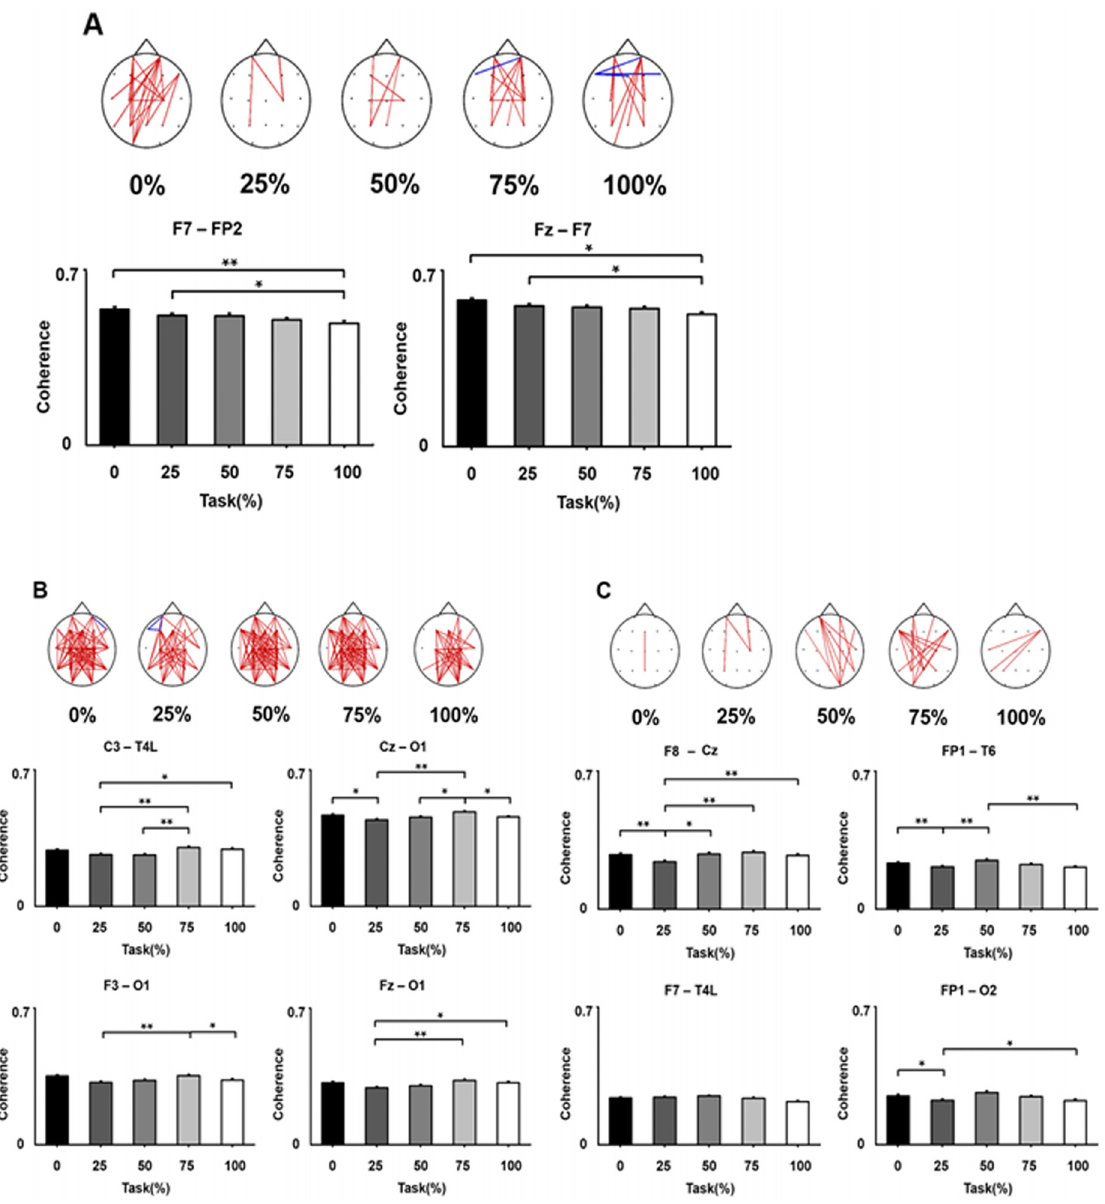
Fig 4. Frequency-specific phase coherence changes over SA modulation. (A) alpha (8 – 12 Hz) band. (B) beta (13 – 30 Hz) band. (C) gamma (31 – 50 Hz) band. In each frequency band, topographic maps show group-averaged, phase coherence. The dots indicate electrode positions. Red lines indicate significant phase coherence increases and blue lines indicate significant phase coherence decreases, compared to the value of phase coherence in the resting condition. Graphs represent the pairs of electrodes showing significant phase coherence changes according to SA modulation. The bar charts show the electrode pairs with significant variations of phase coherence according to SA changes in three frequency bands (alpha, beta, gamma). The asterisks indicate significant differences between the pairs of % control condition (Bonferroni corrected p-values for pair-wise post-hoc analysis). * p < 0.05, ** p <